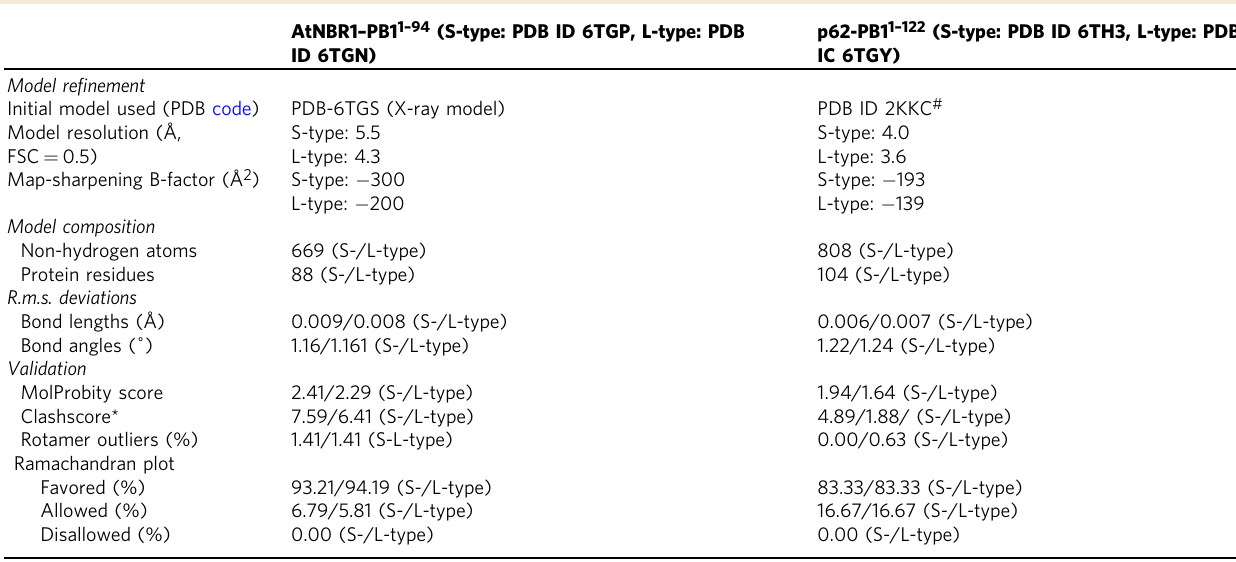
Table 2 Model re fi nement statistics.